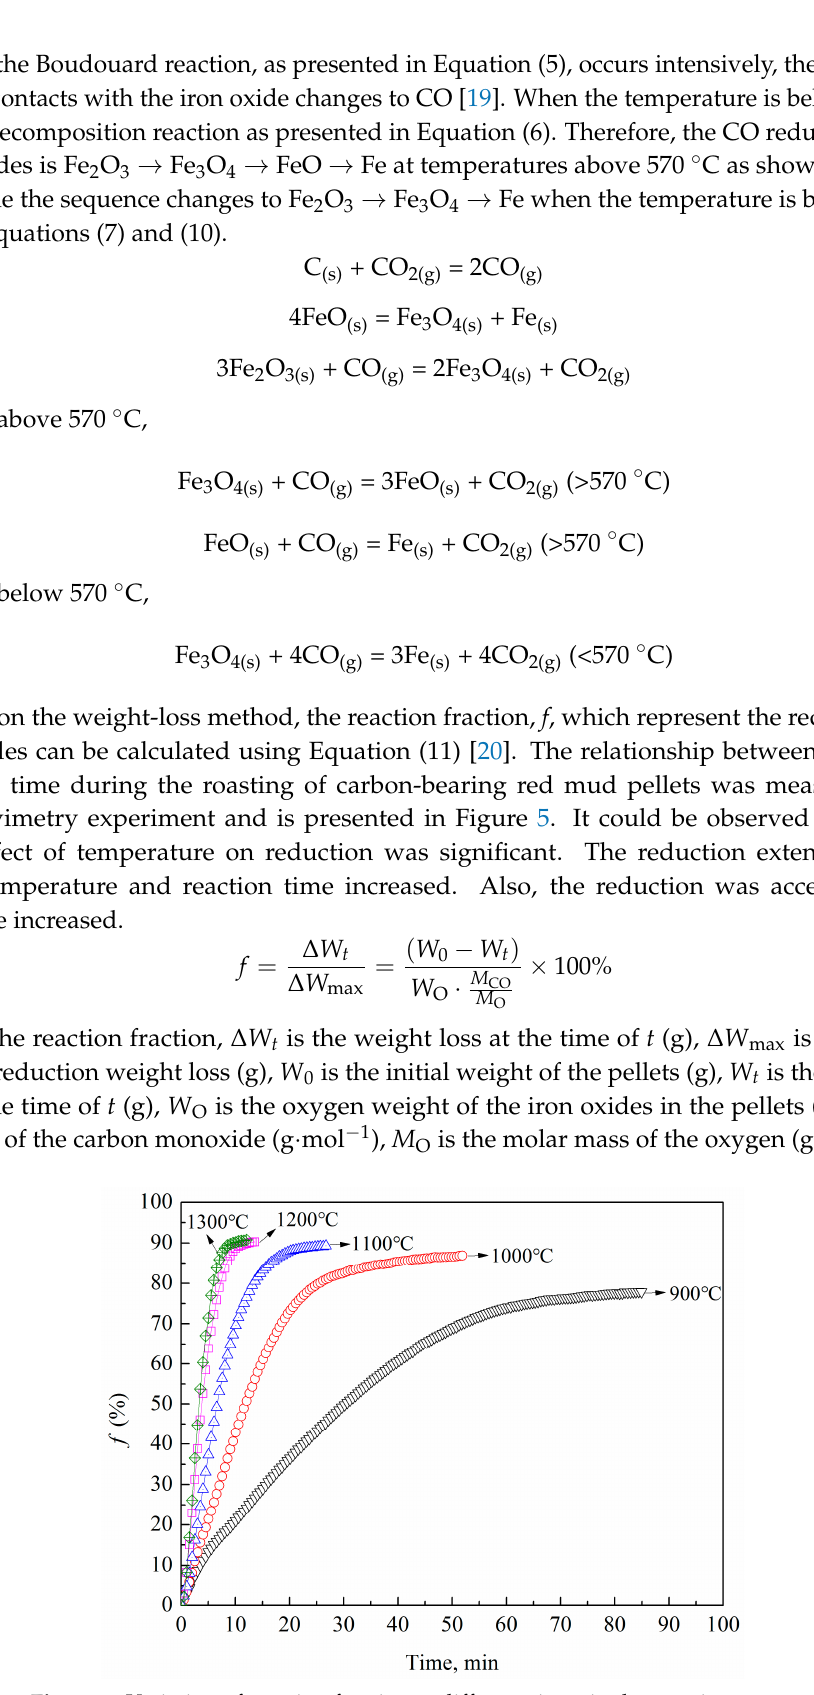
Figure 5. Variation of reaction fraction at different times in the roasting process.